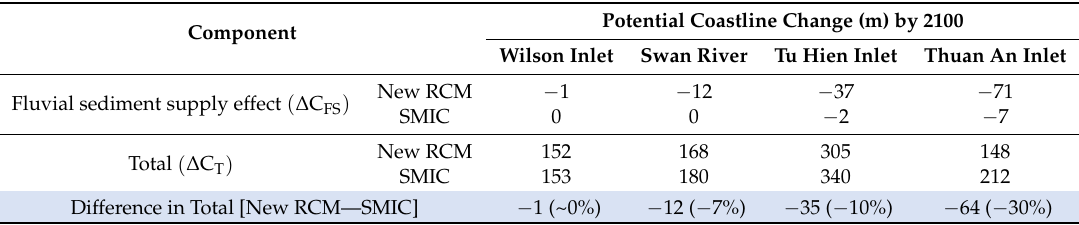
Table 4. Comparison of predicted coastline changes with SMIC predictions.